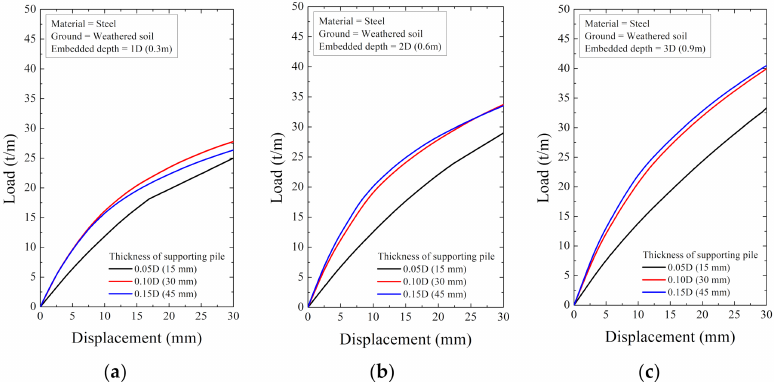
Figure 18. The displacement–load curve when the supporting material is steel in weathered soil at